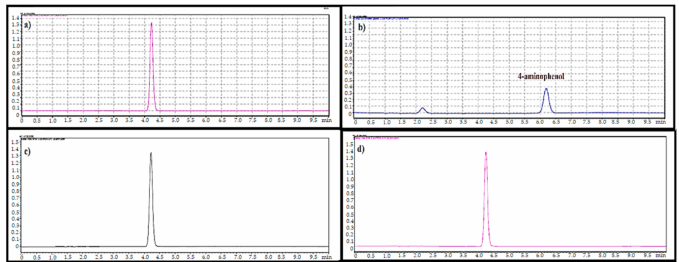
Figure 9. The 4-aminophenol peak in paracetamol instant jelly samples stored in packaging 1: ( a ) no peak in real-time conditions at 0 time point, ( b ) 4-aminophenol peak present in accelerated conditions at 3 months. Samples stored in packaging 2: ( c ) no peak in real-time conditions at 0 time point, ( d ) 4-aminophenol peak present in accelerated conditions at 3